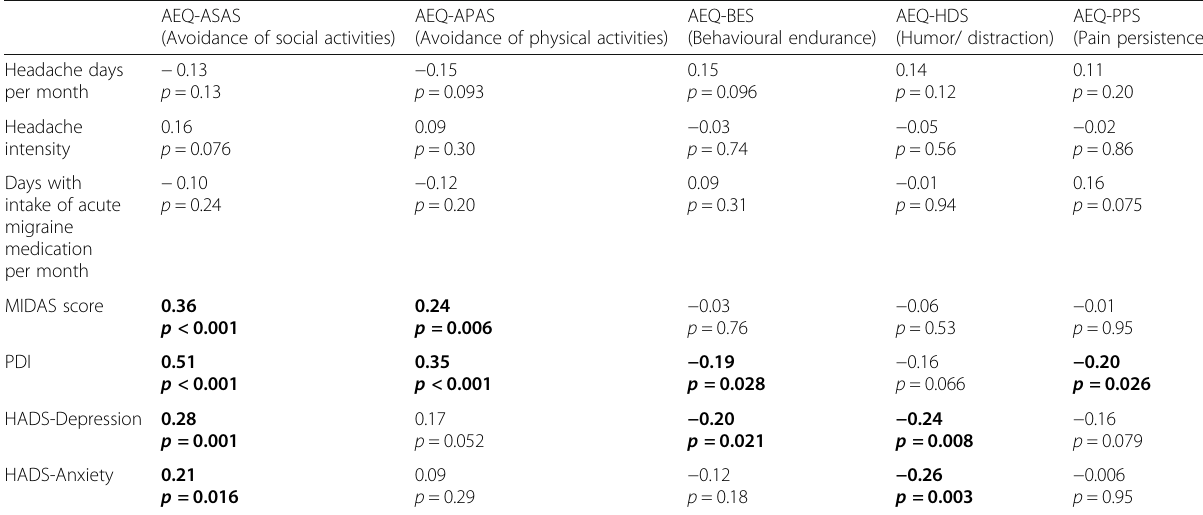
Table 3 Zero-order correlations between headache characteristics, headache-related disability and AEQ behavioural scores ( n = 128) AEQ-ASAS (Avoidance of social activities)